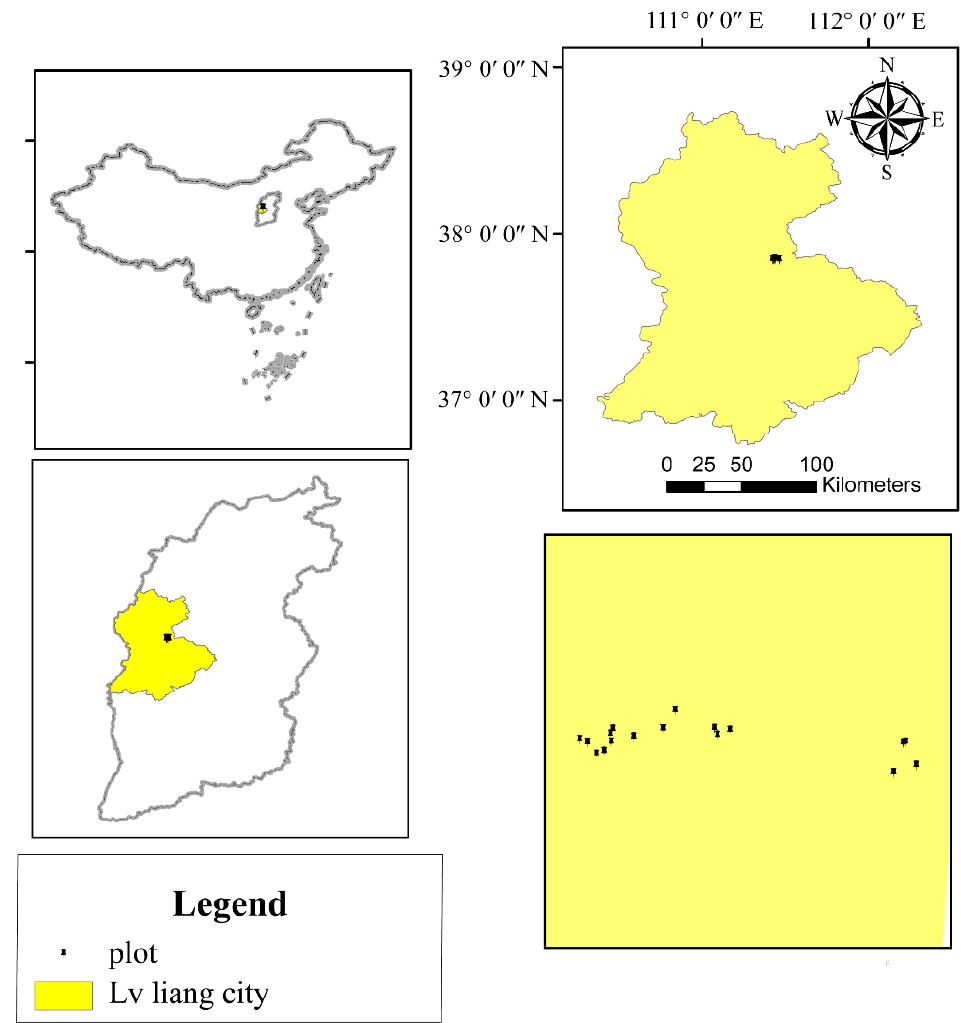
Figure 1. The location of sample plots for the analyses of forest-forming tree species in China. From these plots, the stem analysis data used for model development were collected.